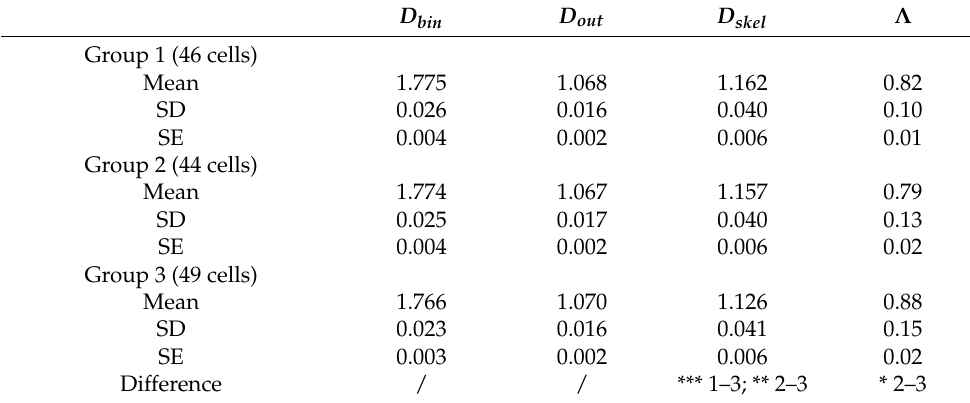
Table 3. Mean values, standard deviation (SD) and standard errors (SE) of four monofractal param- eters ( D bin , D out , D skel and Λ ) in three age groups of multipolar neurons in the human PON. The symbol * indicates the statistical significance between the groups.